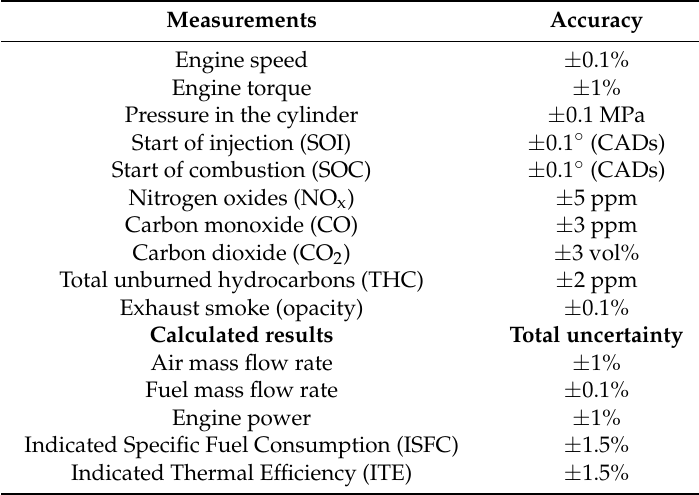
Table 2. The accuracy of the measured engine performance and emission parameters and the uncertainty of the computed experimental